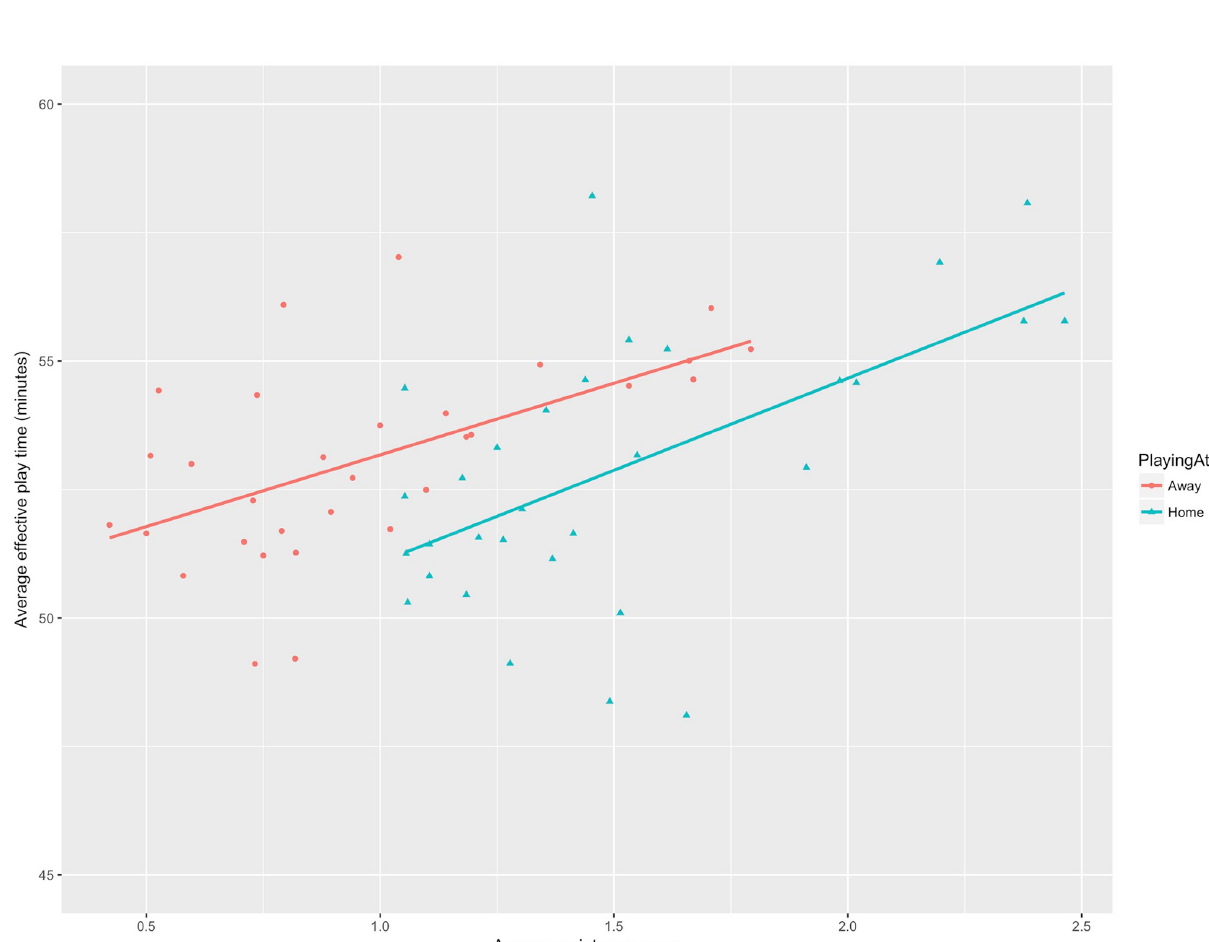
Fig 3. Average effective playing time by average points at home and